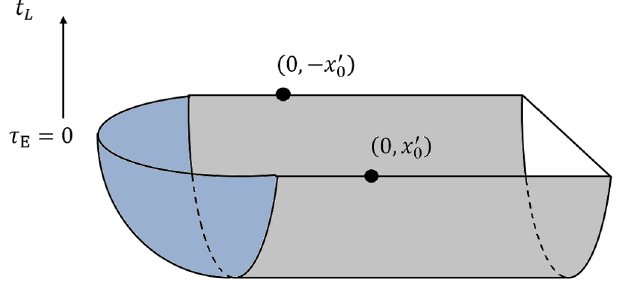
Figure 7 . Thermofield double perspective of the